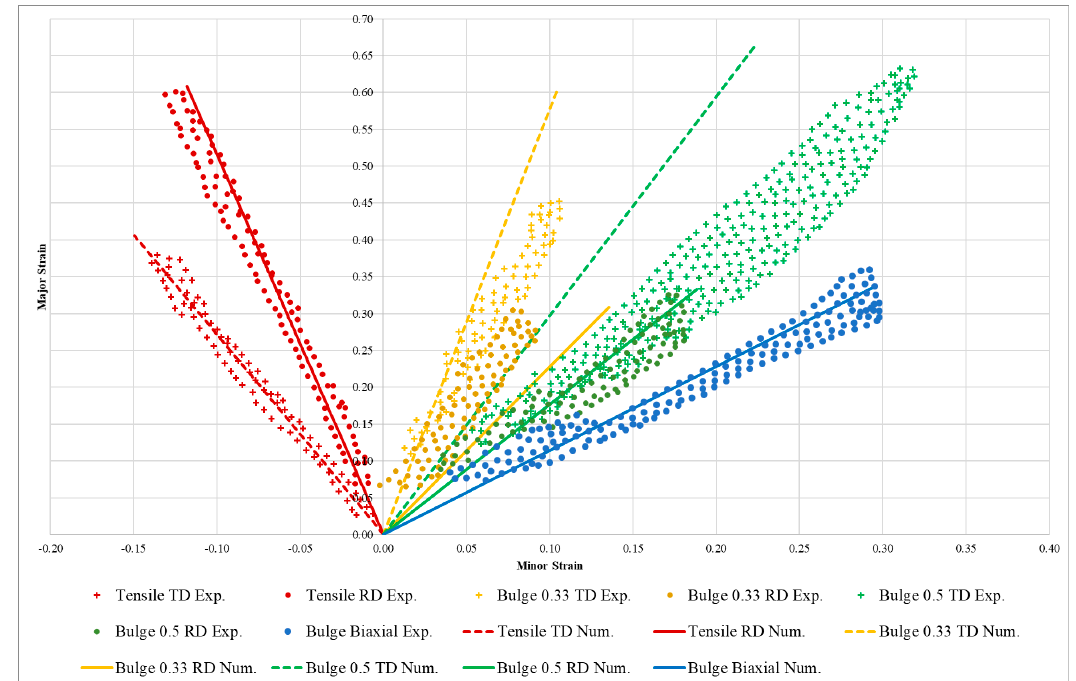
Figure 6. Experimental and numerical strain paths on the major and minor strains diagram from results of the tensile and bulge tests.